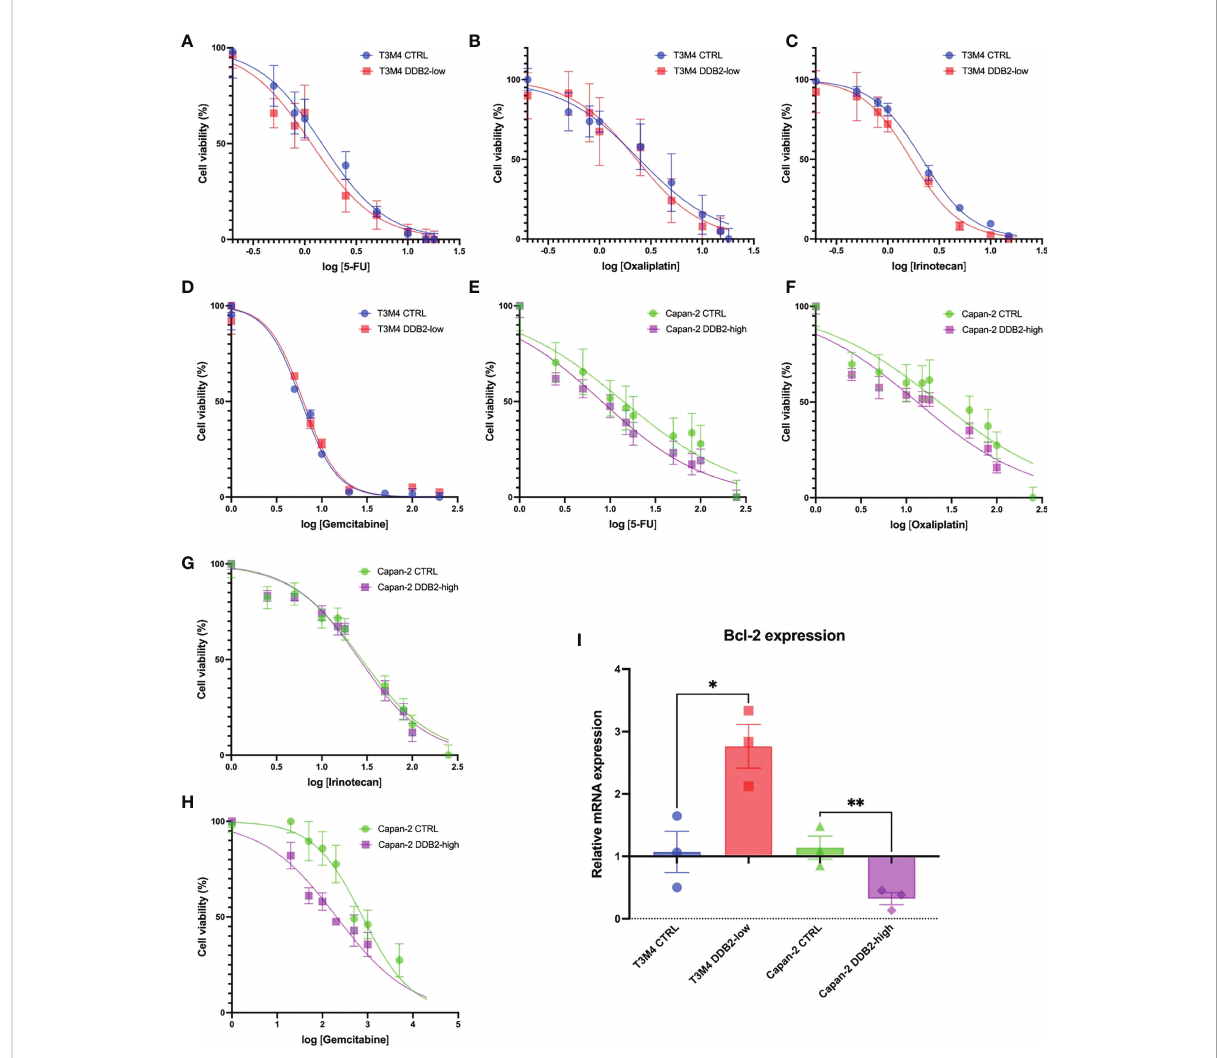
FIGURE 5 Determination of cell viability of T3M4 CTRL, T3M4 DDB2-low, Capan-2 CTRL and Capan-2 DDB2-high. Cells were treated with increasing concentrations of 5-FU (A – E) , oxaliplatin (B – F) , irinotecan (C – G) and gemcitabine (D – H) . Data from 3 independent experiments are expressed as mean ± SEM. (I) Expression of Bcl-2 evaluated by RT-qPCR. b -actin was used as the housekeeping gene, results were normalized according to the expression levels obtained in wild type cells. Data from 3 independent experiments are expressed as mean ± SEM, *p < 0.05, **p < 0.01 (Student ’ s unpaired t test).